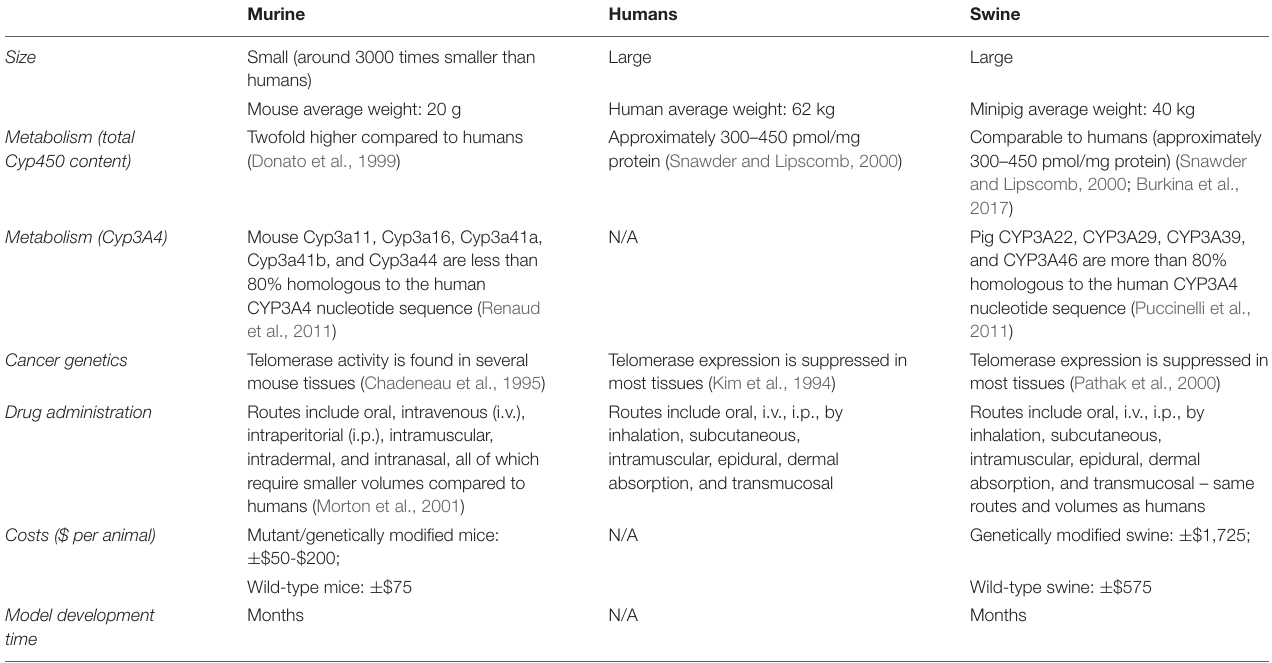
TABLE 1 | Characteristics of murine and swine pre-clinical trial cancer models compared to